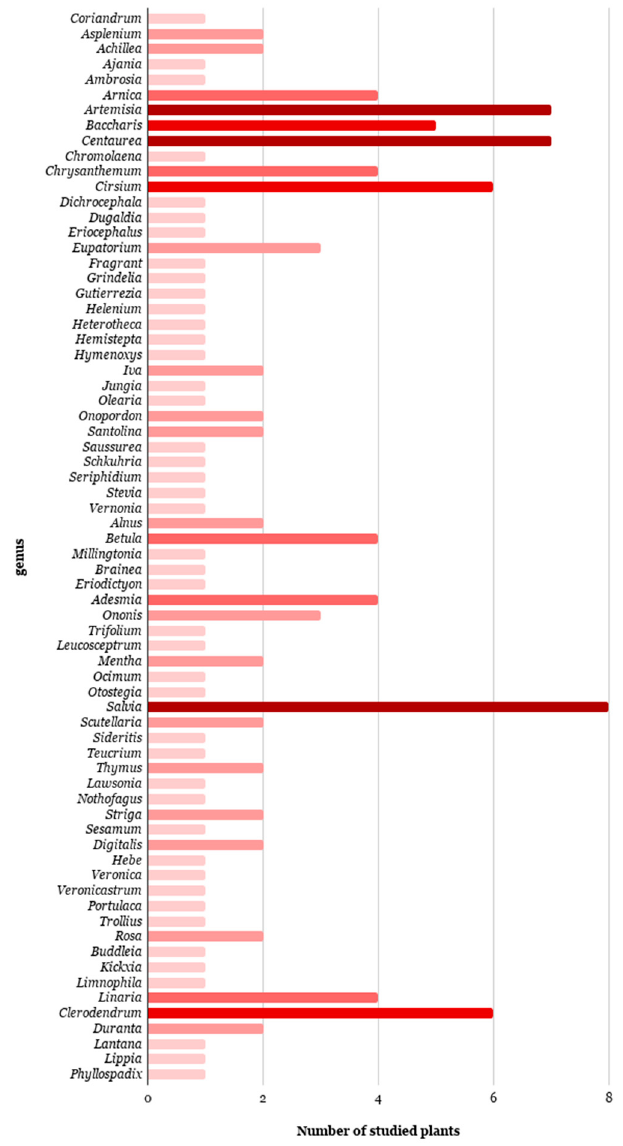
Figure 4. Number of plants investigated for the presence of pectolinarigenin, classified according to their genus.